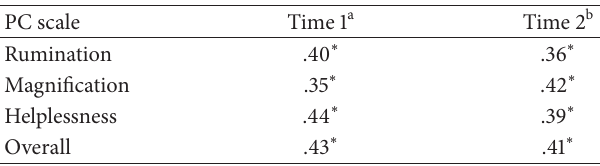
Table 3: Correlations between number of postconcussion symp- toms and pain catastrophizing (PC) scores at 1 month and 8 weeks following mild traumatic brain injury (MTBI).